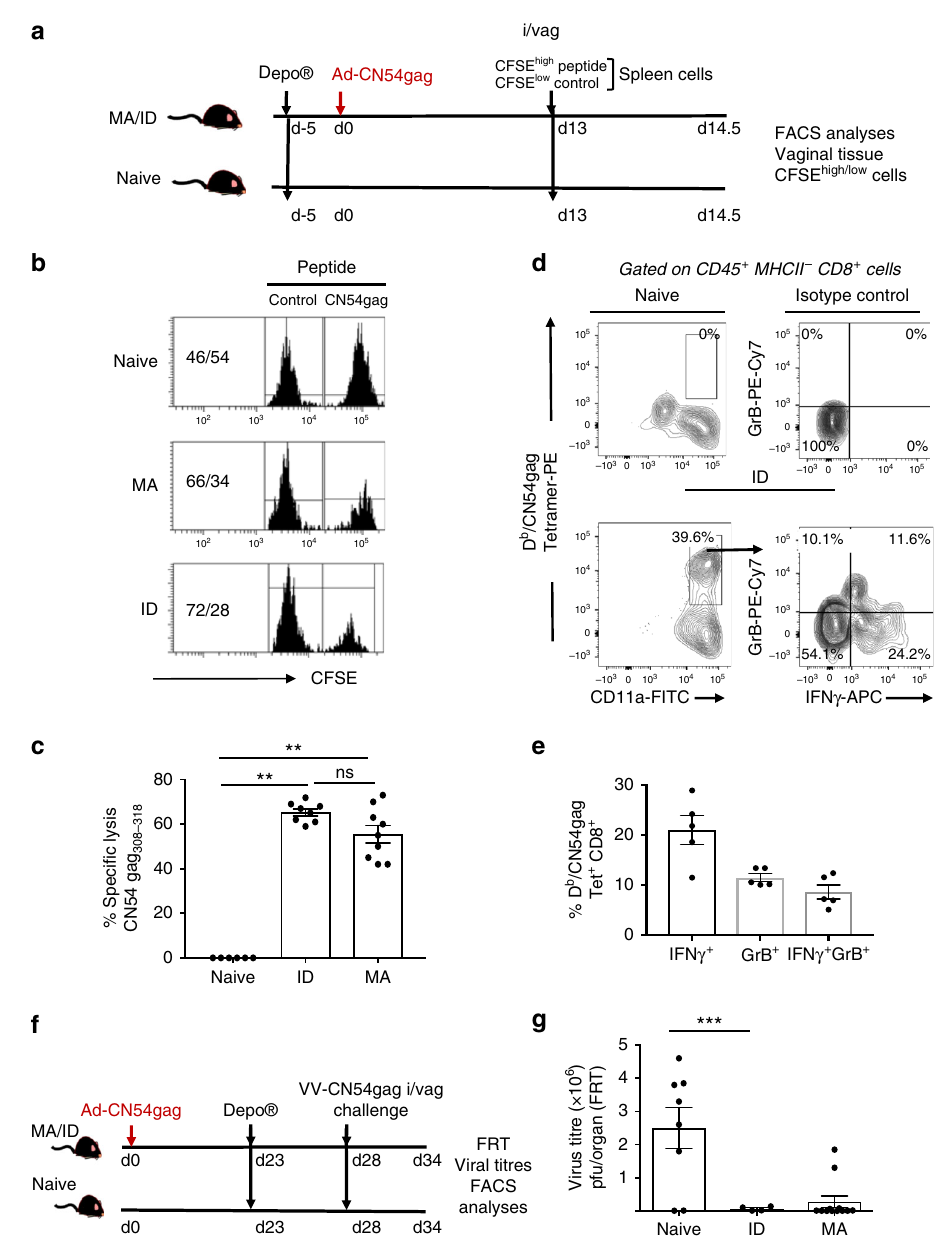
Fig. 2 FRT CD8 + T cells induced by skin immunisation are cytolytic and protect against vaginal virus challenge. a Experimental design. Syngeneic donor spleen cells pulsed with peptide to the immunodominant Db/HIV-1 CN54 gag epitope (CFSE high ) and control non-pulsed (CFSE low ) syngeneic donor spleen cells (10 6 at 1:1 ratio) were injected into the vaginal mucosa of Depo-Provera treated, Ad-CN54 gag immunised /naive mice. After 18 h, CFSE- labelled donor cells isolated from the vaginal mucosa analysed by fl ow cytometry. b Representative fl ow-cytometry CFSE pro fi les. c Percentage-speci fi c lysis of HIV-1 CN54 gag peptide-coated donor cells in vagina of recipient mice. Data are from two independent experiments ( n = 6 – 9 mice /group), ** p < 0.01 by one-way ANOVA, error bars show s.e.m. d , e Representative fl ow-cytometry pro fi les and summary graph of IFN γ and/or Granzyme B expressed by CD8 + T cells isolated from FRT tissue 14 days after Ad-CN54 gag skin immunisation and stimulated in vitro with peptide speci fi c to the immunodominant Db/CN54 gag epitope. Data represent n = 5 mice/group. f Experimental design for testing host protection from vaginal infection with rVV-CN54gag (5 × 10 7 pfu) conferred by skin immunisation (ID or MA) with Ad-CN54gag. g Virus (VV) titres in the vaginal mucosa were measured by plaque assay on day 6 post virus challenge. Data are representative of two independent experiments with a total of 4 – 12 mice per group. *** p < 0.001 by one-way ANOVA, error bars show s.e.m the Ad5 genome content detected in the FRT after skin immu- greater than the Ad genome content (per 100 ng of DNA) in nisation. Tracking by tetramer did not reveal D b /CN54 gag Tet + blood (Fig. 3a, b), indicating that virus biodistributed from the CD8 + T cells in the iliac LNs (Fig. 3c) or FRT at day 7 or 14 after skin to peripheral non-lymphoid tissues. The capacity of this low intravaginal immunisation with 3.5 × 10 2 vp Ad -CN54 gag dose of biodistributed virus particles to prime CD8 + T cells locally in the vaginal mucosa was assessed by intravaginal injection of (Fig. 3d; Supplementary Fig. 3). In contrast, the skin-priming naive mice with 3.5 × 10 2 vp Ad-CN54 gag that was equivalent to dose (1 × 10 9 vp) when injected intravaginally elicited a high NATURE COMMUNICATIONS| (2019) 10:2214